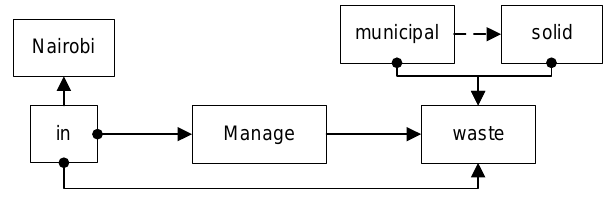
Figure 4. ROM diagram of the concept statement.